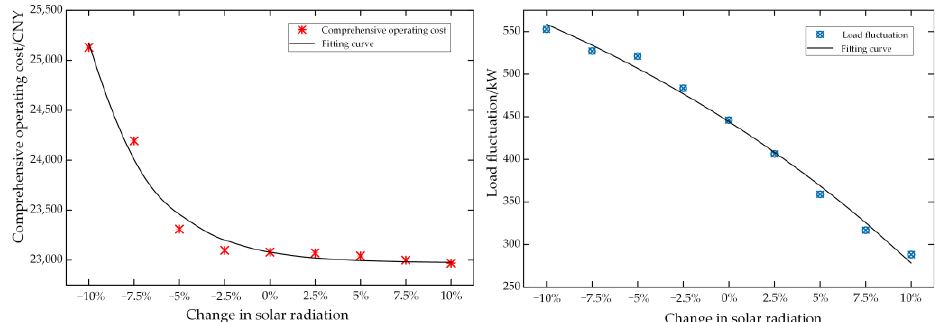
Figure 13. Influence of solar radiation of −1 0% – 10% on operating results.